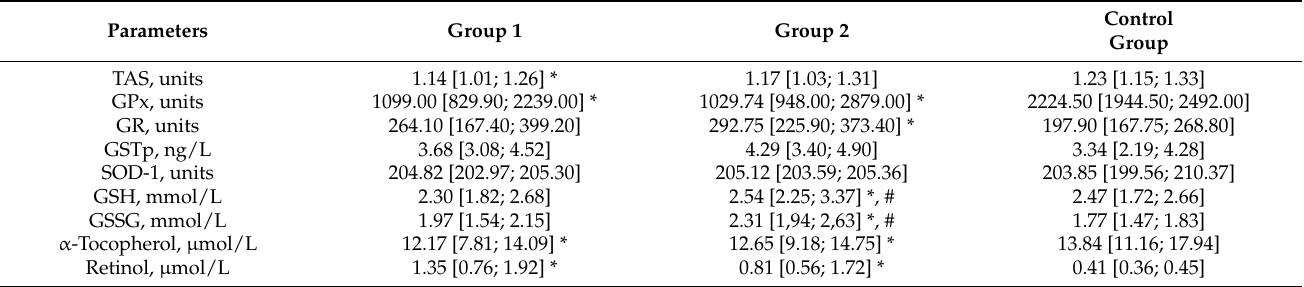
Table 5. Total antioxidant status, enzymatic and non-enzymatic antioxidant levels in men with T1DM (Me, [Q1; Q3]).